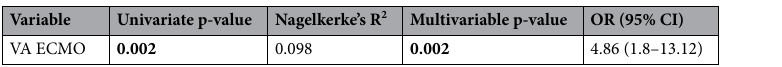
Table 2. Multivariable regression analysis predicting brain infarction during extracorporeal membrane oxygenation. Final results from the step-down multivariable logistic regression analysis that originally included the variables VA ECMO, SAPS-3, pre-ECMO cardiac arrest, GCS and conversion of modality. Bold text in the p value column indicates a statistically significant correlation (p < 0.05). ECMO extracorporeal